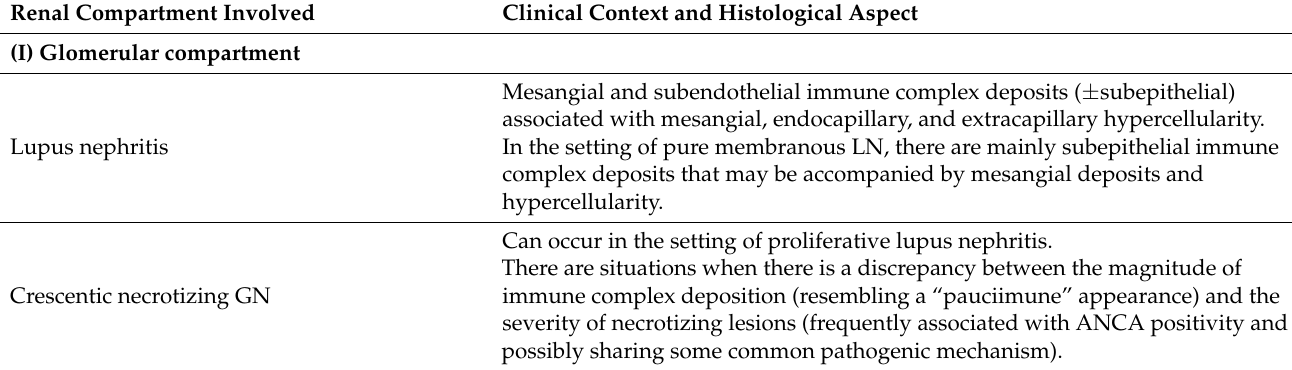
Table 1. The types of renal injury in SLE (adapted after [13–16]). Renal Compartment Involved Clinical Context and Histological